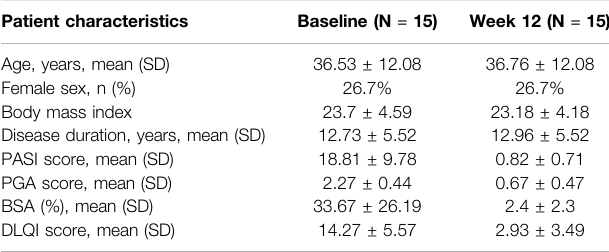
TABLE 2 | Details of moderate-to-severe plaque psoriasis patients treated with secukinumab. Patient characteristics